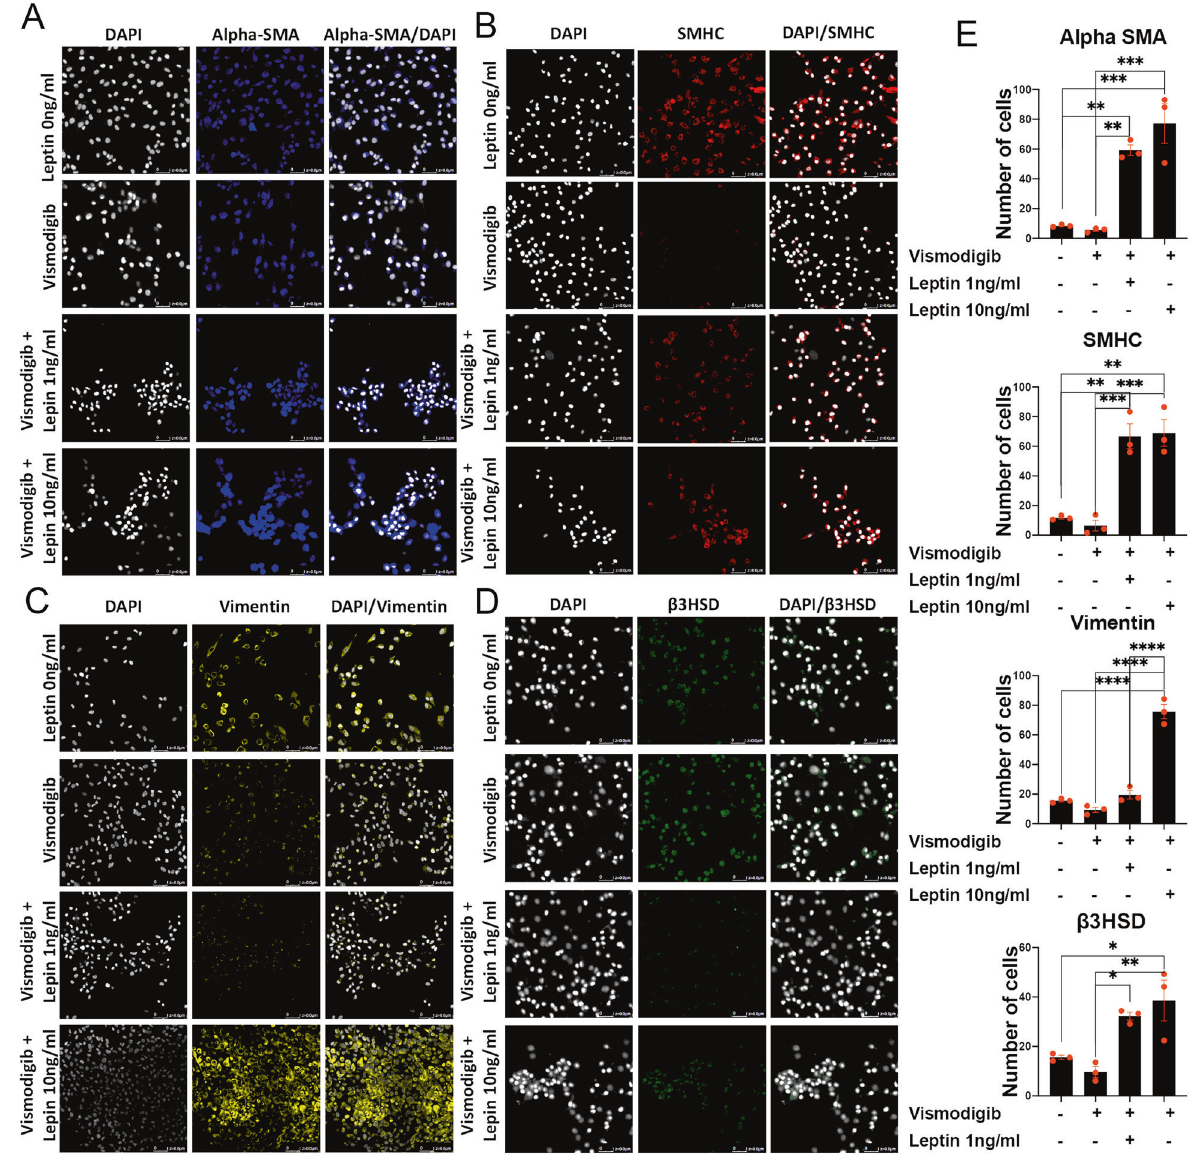
Fig. 5 Leptin in fl uences LSCs through DHH signaling. Leptin augments LSCs through DHH signaling. Cells (LSCs, ALCs, Sertoli cells, PMCs) were treated with Vismodigib (DHH antagonist) in the presence of Leptin (1 or 10 ng/ml). Immunostaining showing expression of A alpha SMA, B SMHC, C Vimentin, and D B3HSD upon post-Vismodigib and leptin treatment. E Quanti fi cation of the experimental data to compare the effects of treatment. Asterisks denote p values (e.g., * p < 0.05, **** p <